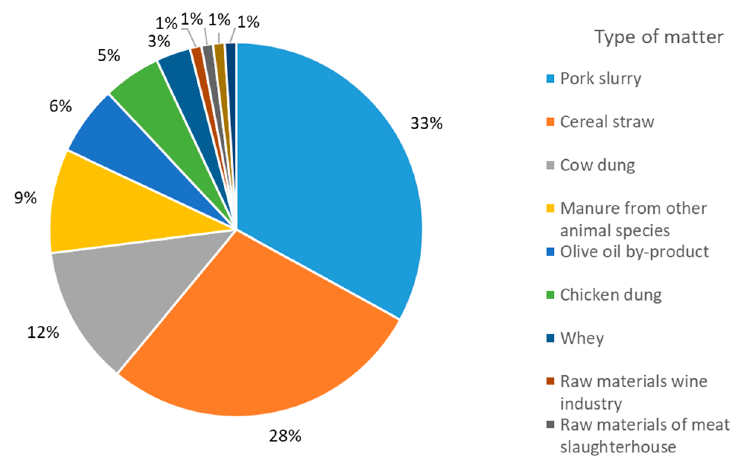
Figure 2. Volume distribution of the studied materials in Spain (data from [20]).